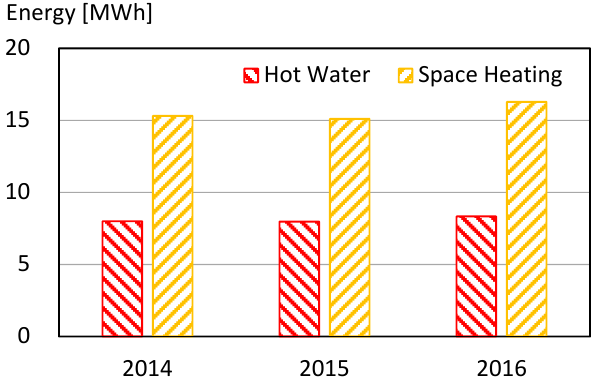
Figure 13. Measured yearly heating and hot water loads.